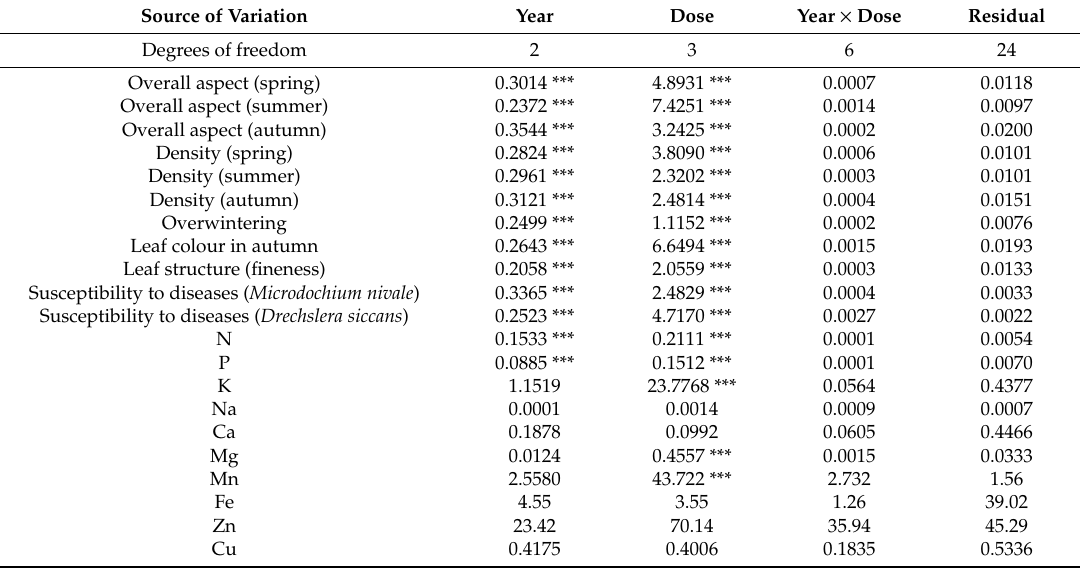
Table 2. Mean squares from two-way analysis of variance for lawn grass characteristics.